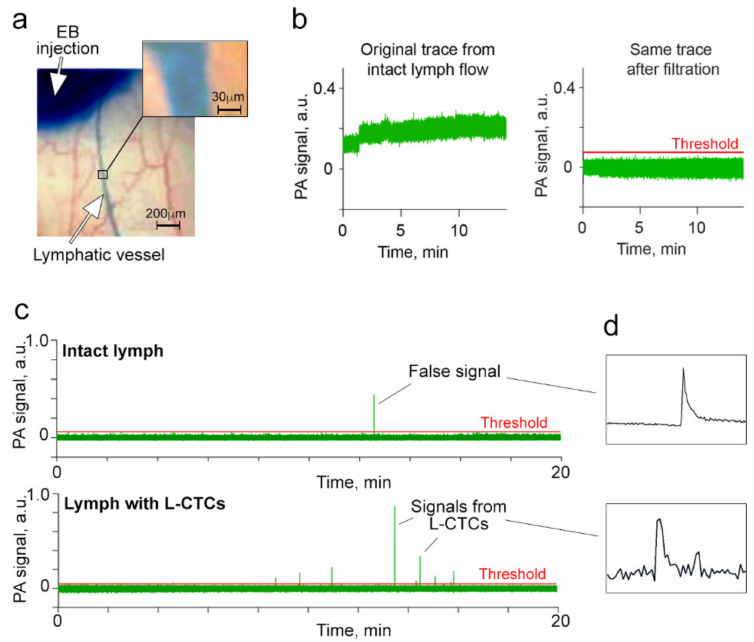
Figure 2. Optimization of photoacoustic (PA) flow cytometry (PAFC) to assess L-CTCs in mice in vivo. ( a ) Evans Blue (EB) lymphography of ear a ff erent lymphatic vessels. ( b ) The PA trace recorded from the intact (control) lymph without false signals before (left) and after (right) high-pass filtration. ( c ) The PA trace recorded from the intact (control) lymph with one false signal and from the lymph with melanoma L-CTCs. ( d ) The representative peak shapes from PA traces identified as artifact-associated false signal (top) and CTC-associated signal (bottom). The examples of eight independent experiments of control mice and five melanoma-bearing mice are shown in